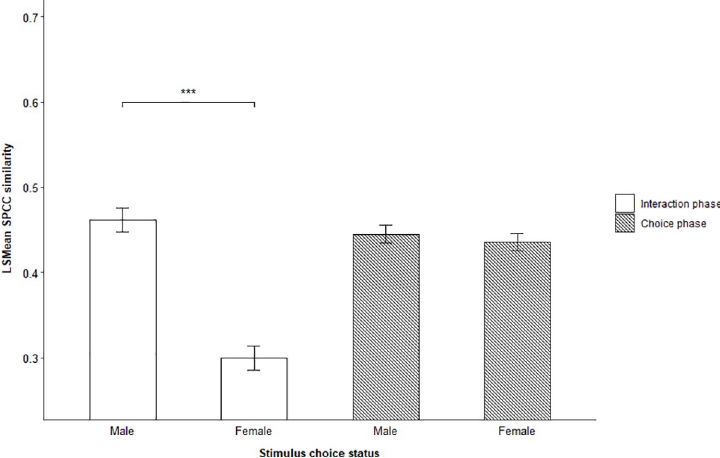
Fig 6. Effect of chosen sex on stimulus-response similarity. LSMean ( ± SE) spectrographic cross-correlation (SPCC) similarity between stimulus calls and focal flock responses emitted during the interaction and choice phase of male- female trials. The figure shows the difference between males and females that were chosen by focal flocks. Significant selected pairwise comparisons are indicated with asterisks.